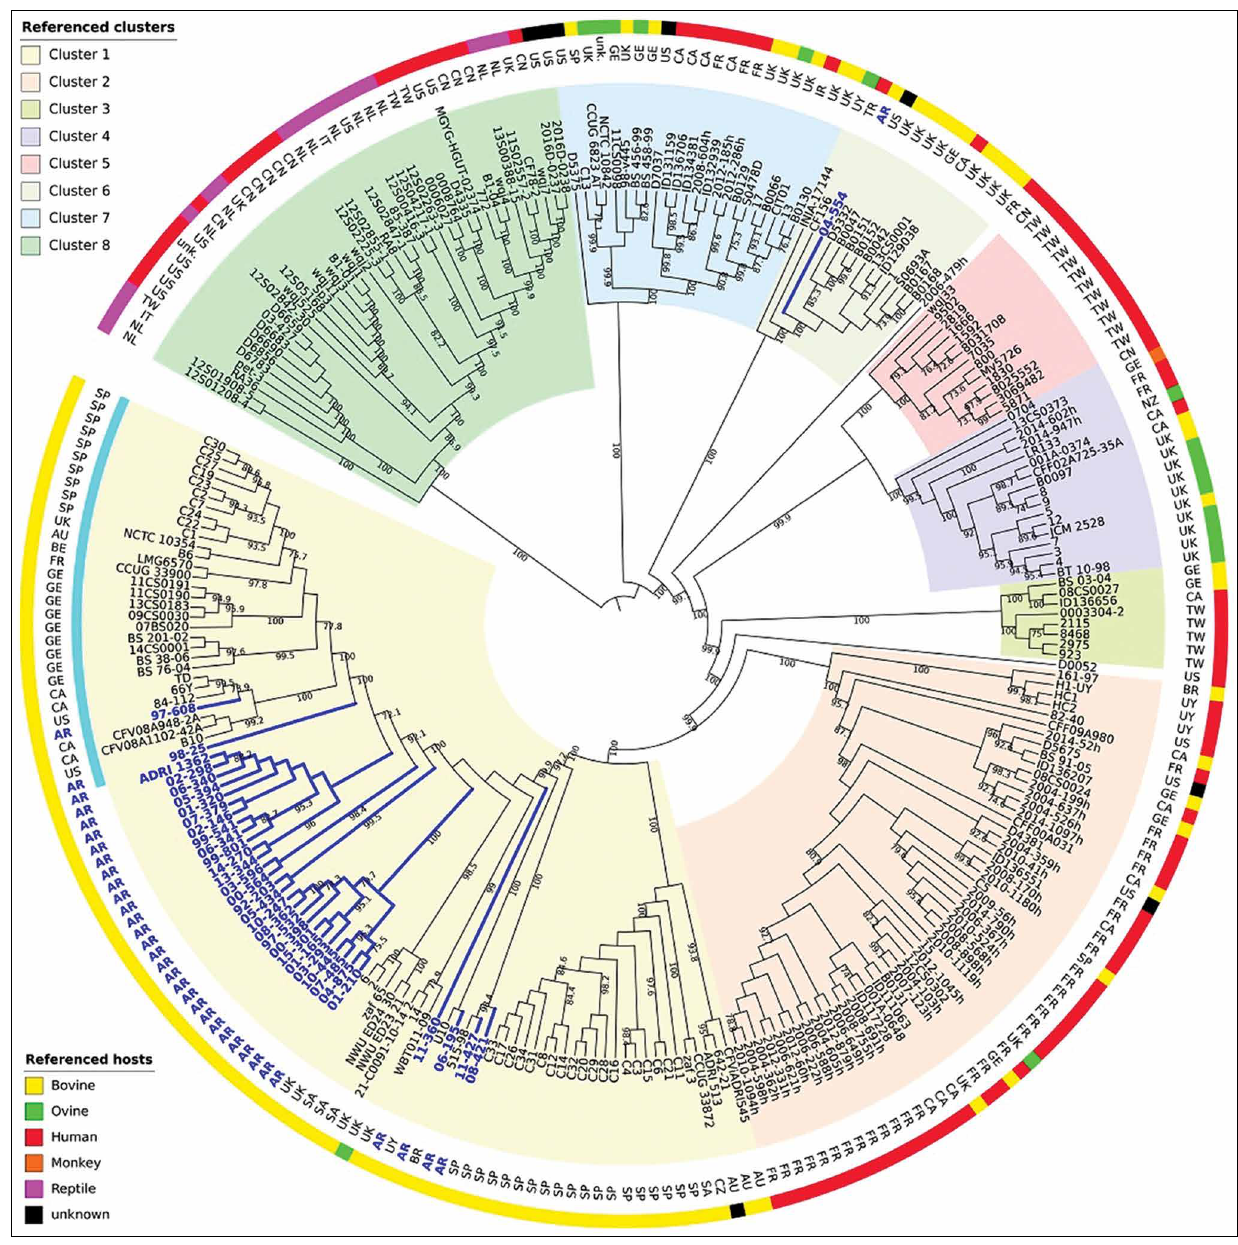
Figure-3: Global phylogeny of Campylobacter fetus based on core genome. Maximum likelihood tree based on 1143 single-copy genes shared by 265 C. fetus strains. The nodes and clusters colored in blue refer to the Argentine strains (n=34). The turquoise line refers to the subcluster of strains identified as Campylobacter fetus venerealis (n=31). Country code: AR=Argentina, AU=Australia, BE=Belgium, BR=Brazil, CA=Canada, CN=China, CZ=Czech Republic, FR=France, GE=Germany, IT=Italy, IR=Ireland, NL=The Netherlands, NZ=New Zealand, SA=South Africa, SP=Spain, TK=Turkey, TW=Taiwan, UK=The United Kingdom, UY=Uruguay, USA=The United